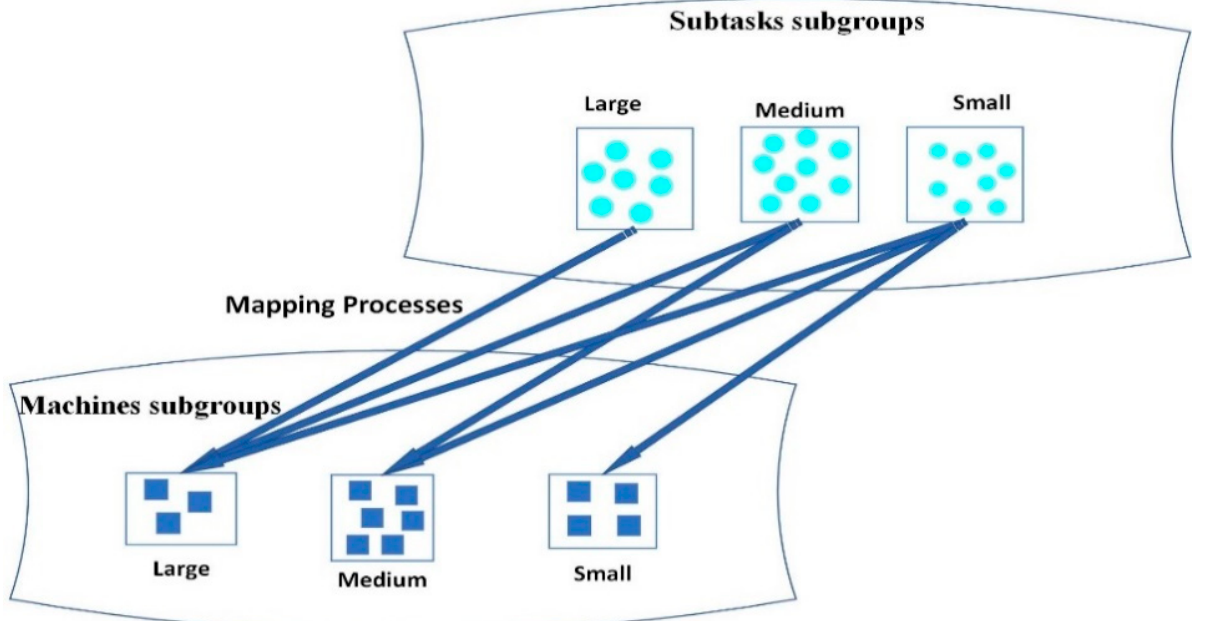
Figure 2. Mapping tasks to appropriate devices.